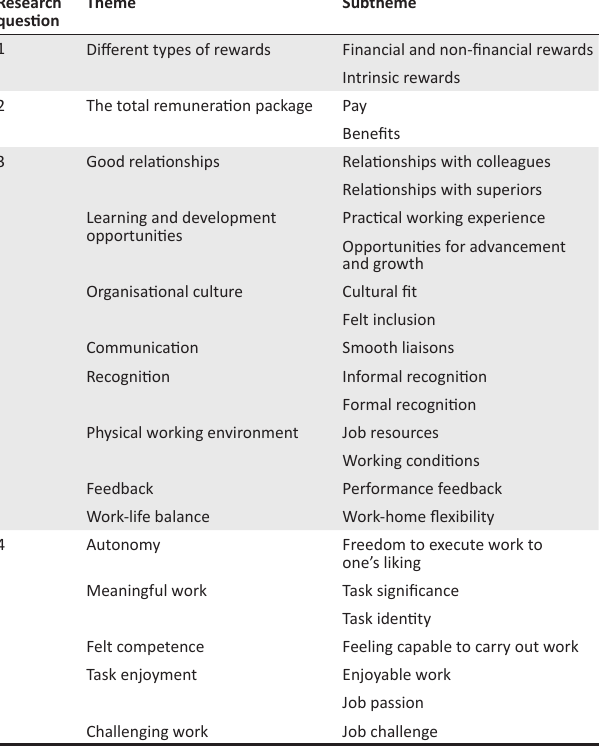
TABLE 4: Themes and